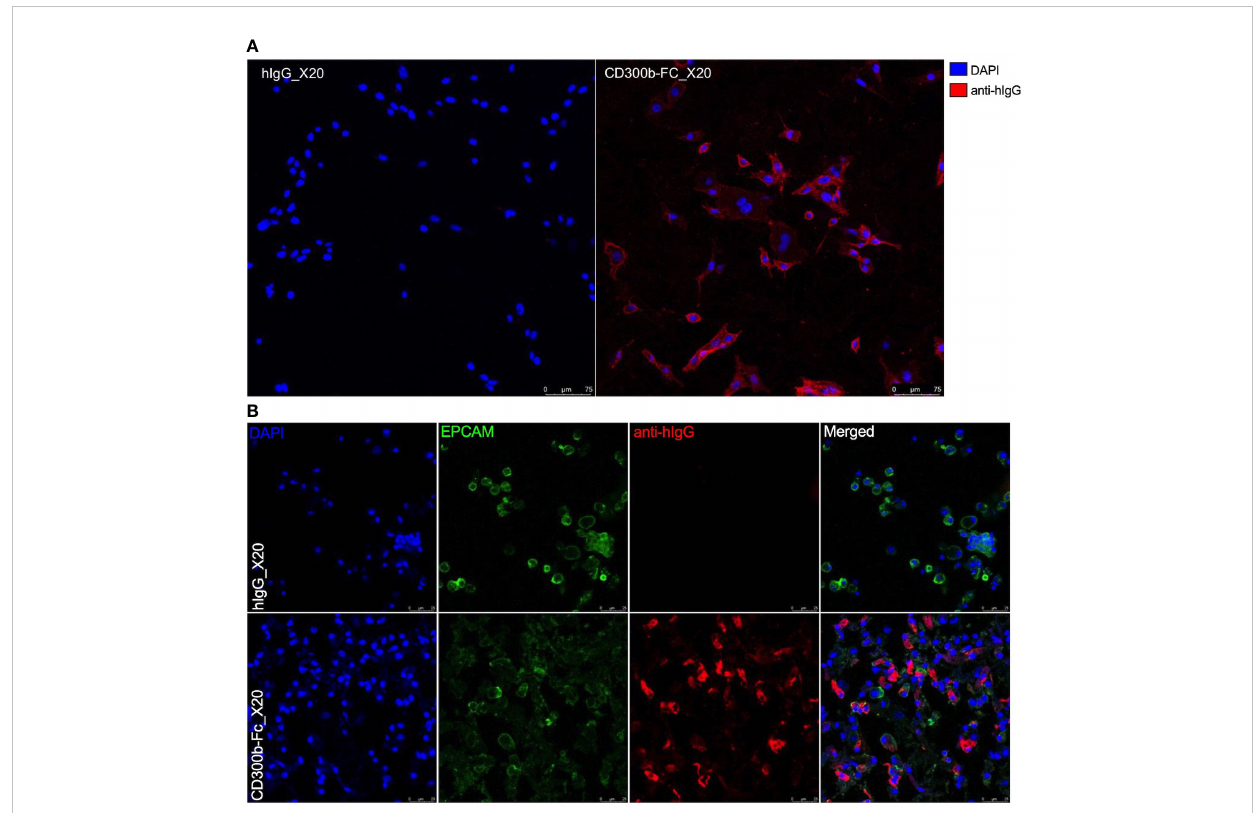
FIGURE 2 Immuno fl uorescence of CD300b-Fc colonic epithelial cell binding. Mouse MC38 epithelial cells (A) or primary colonic epithelial cells (B) were incubated with hIgG1 or CD300b-Fc IgG1 fusion protein. Subsequently, the cells were incubated with donkey anti hIgG conjugated to Alexa fl our 647. Epithelial cells were stained with nuclear staining (DAPI, A, B ) and primary colonic epithelial cells were identi fi ed as EpCAM (EPCAM) + cells (B) . Representative photomicrographs are